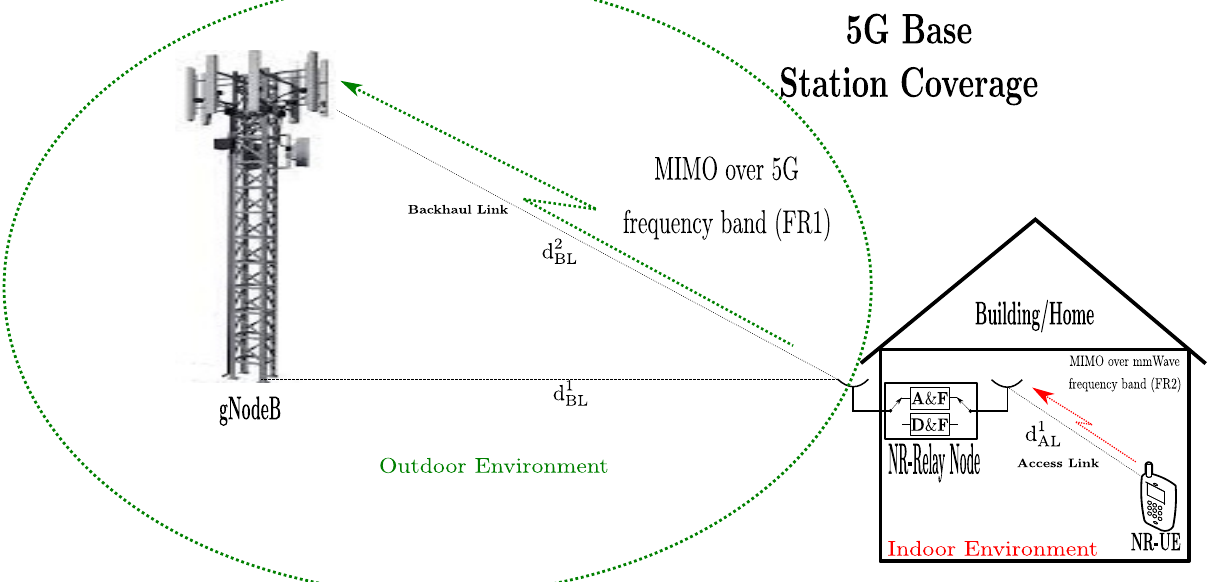
Figure 8. Indoor-to-outdoor environment scenario with uplink mmWave MIMO new radio relay